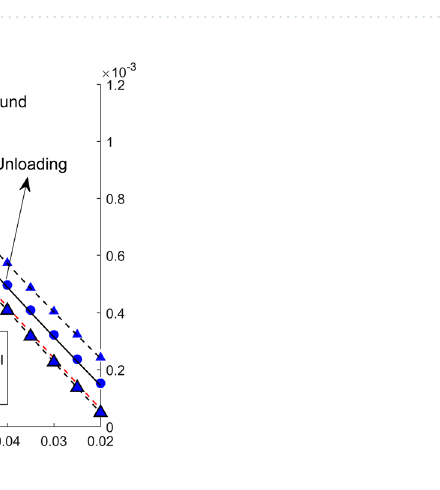
Figure 15. Deterministic load–displacement curves obtained by the target model, HSGPR model and FNN model given by Huang et. al. 37 .